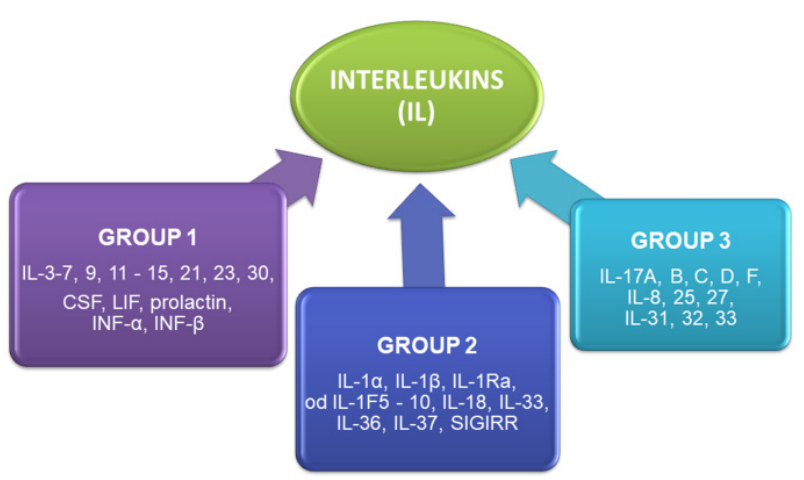
Figure 3. Major interleukin groups.